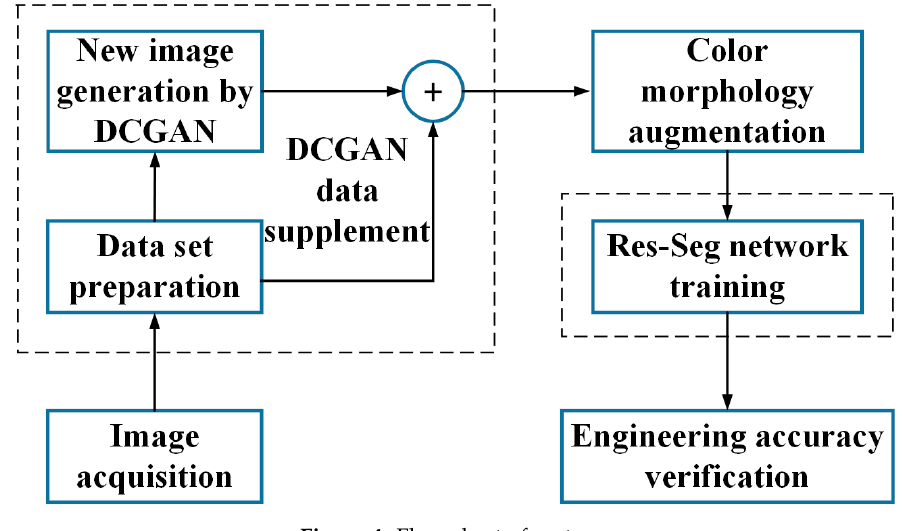
Figure 4. Flow chart of system.